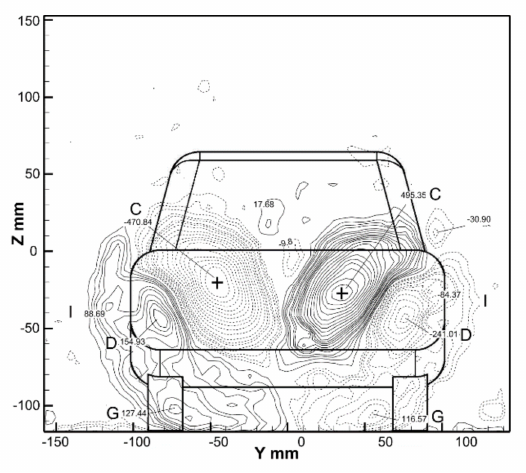
Figure 8. Iso-contours of time-averaged stream-wise vorticity, ω x in the y–z plane at x/H = 0.67. Min- imum and incremental values of vorticity are ω x,min = − 9.804 s − 1 , 17.676 s − 1 , and ∆ ω x = 24.774 s − 1 , respectively.